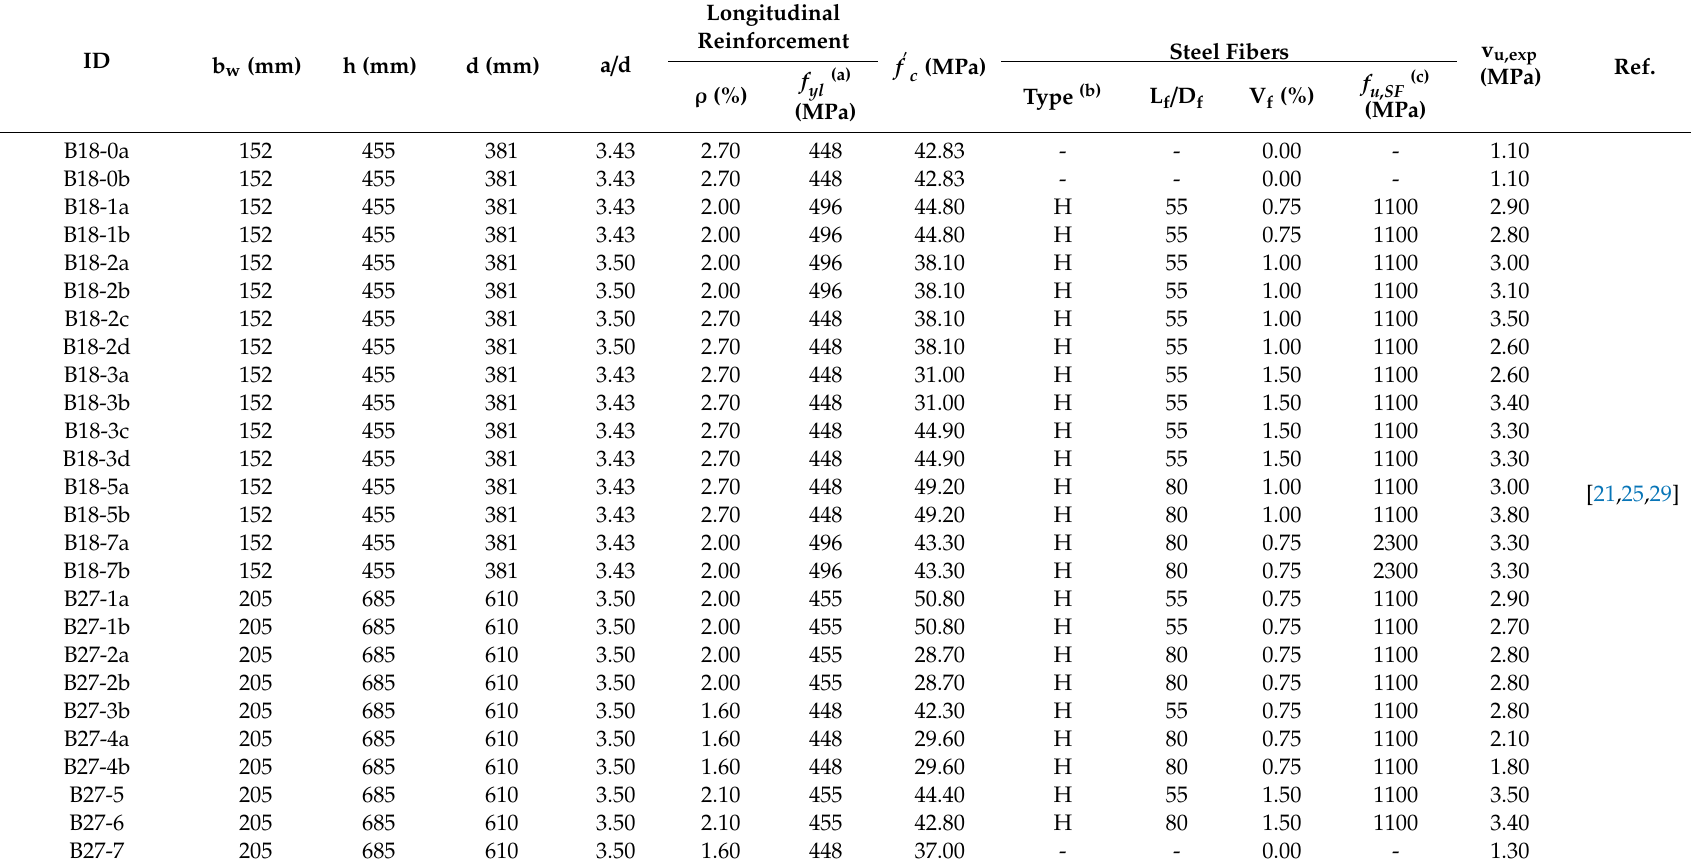
Table A1. Normal reinforced concrete and steel fiber reinforced concrete (SFRC) beam